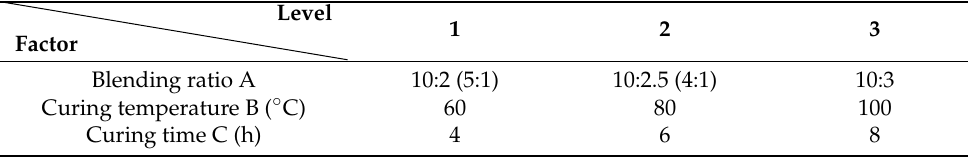
Table 1. The various factors and levels for the polyurethane